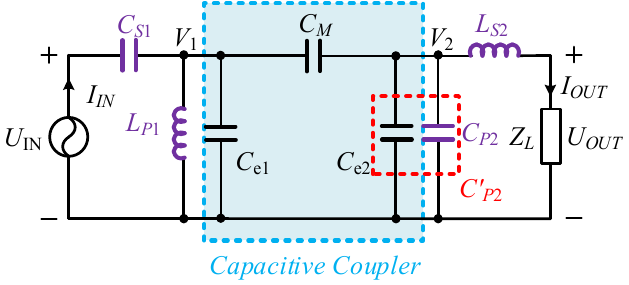
Figure 9. CL − LC compensation topology with π -type coupler model.